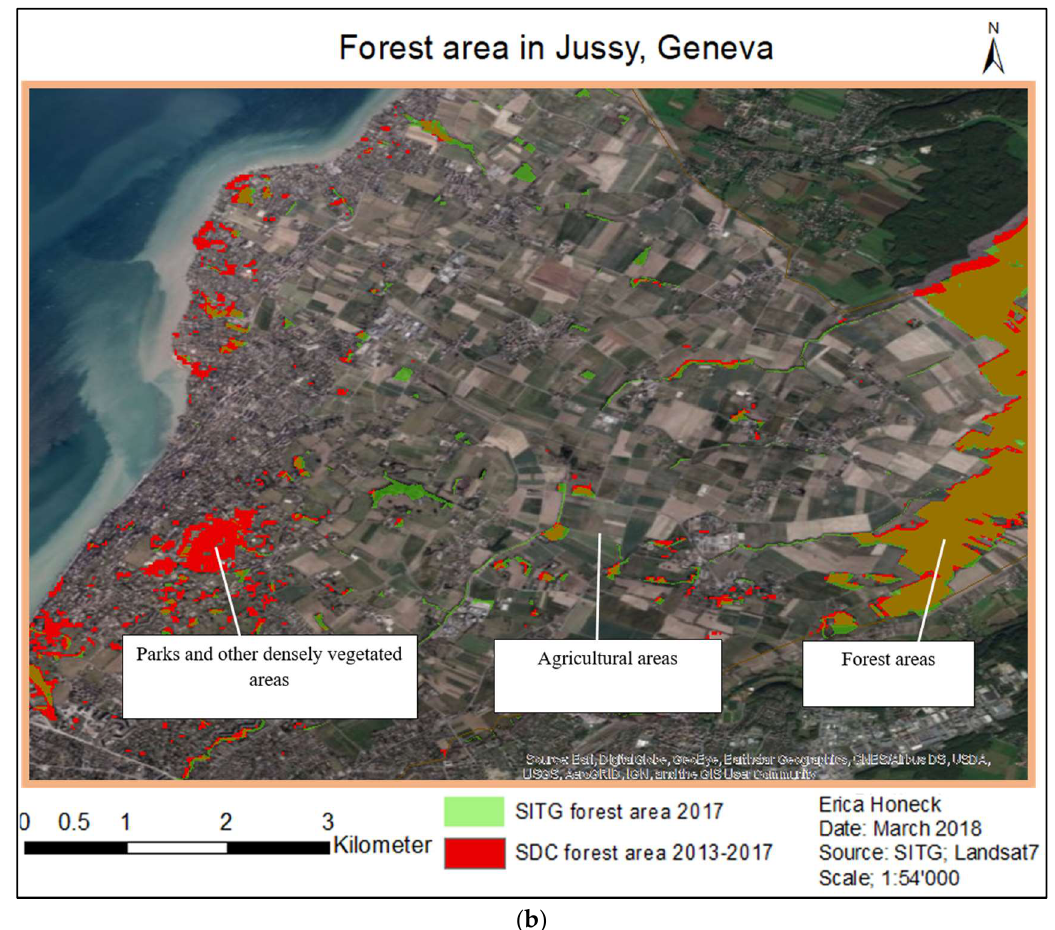
Figure 6. Overlay of forest area estimated with the SDC and the official forest area layer ( a ) (above) and a zoomed area of the overlay with a base map ( b ) (below). The overlap between the red and green layers appears brown. (created with ArcMap 2018).